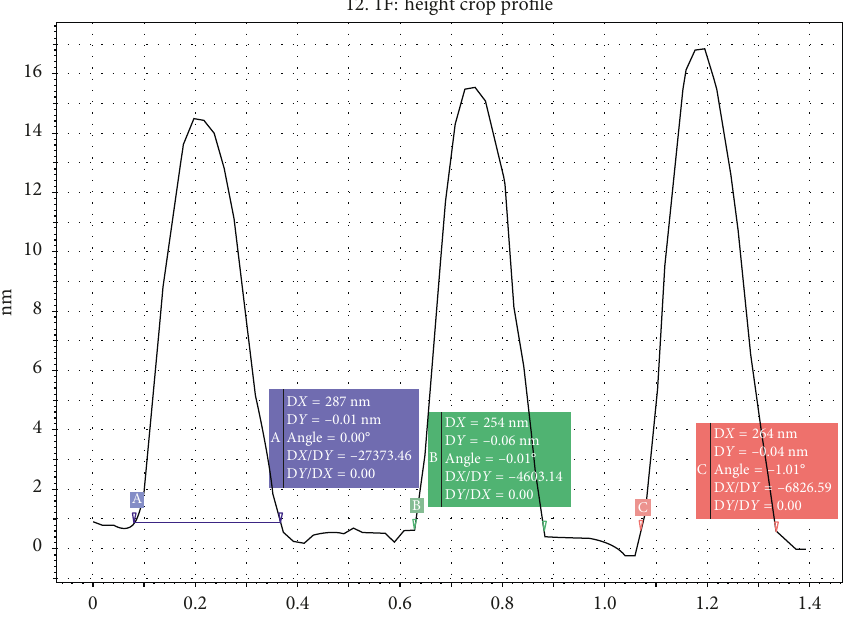
Figure 10: The linear dimensions of the “hillocks” corresponding to the indicated points 1, 2 and 3 in Figure